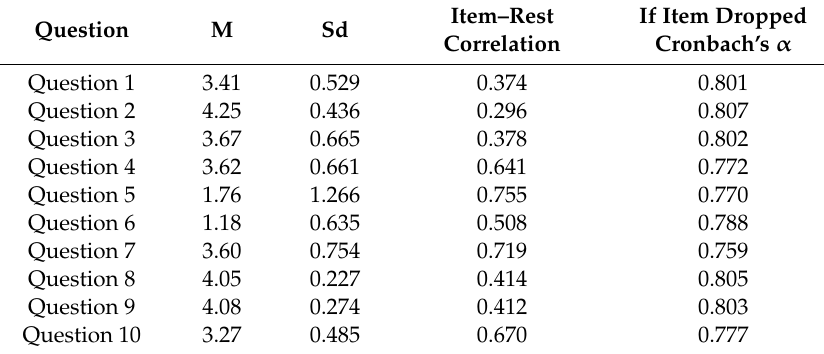
Table 7. Item reliability statistics.